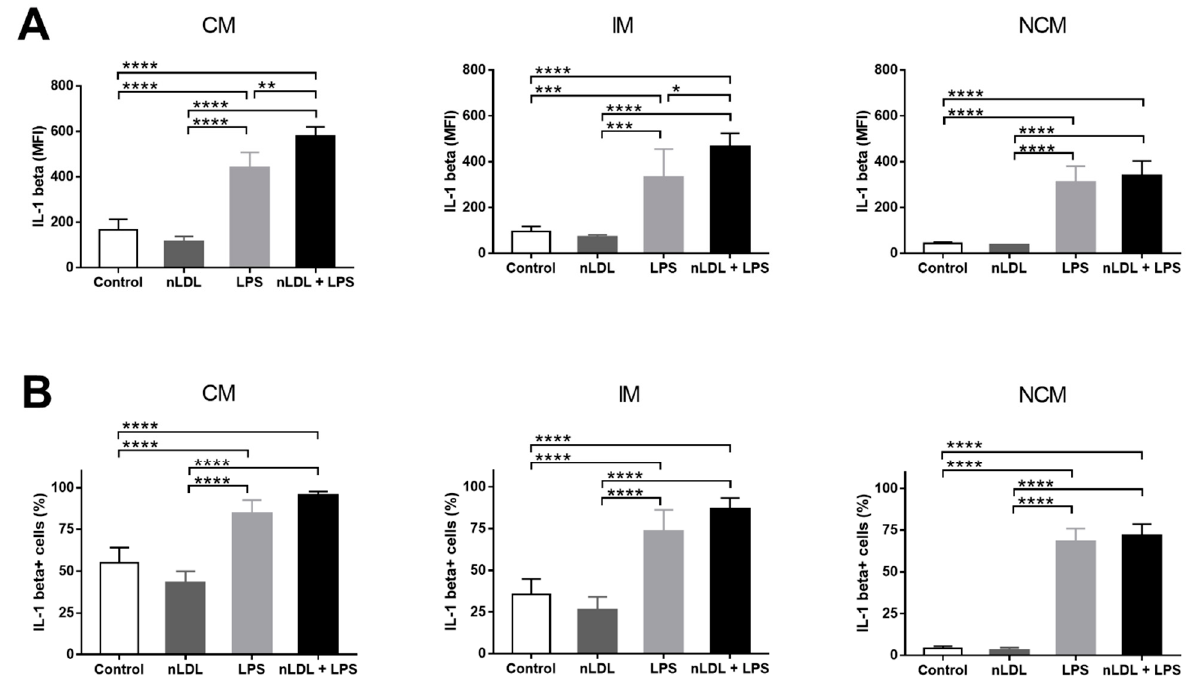
Figure 3. Effects of nLDL and LPS on IL-1 beta production in human monocyte subpopulations. Although no significant differences were found, nLDL tended to decrease IL-1 beta production in CMs, IMs, and NCMs ( A , left, middle, and right panels, respectively). LPS, alone or in combination with nLDL, significantly increased IL-1 beta expression in CMs, IMs, and NCMs ( A , left, middle, and right panels, respectively). Although no significant differences were found, nLDL tended to decrease the percentages of IL-1 beta+ cells in all monocyte subsets ( B , left, middle, and right panels, respectively). LPS, alone or in combination with nLDL, significantly increased the amount of IL-1 beta+ cells in all monocyte subpopulations ( B , left, middle, and right panels, respectively). Cells were incubated in the presence or absence of 100 μ g/mL nLDL and/or 10 ng/mL LPS for 9 h. Data are expressed as mean ± standard deviation. Data were compared using one-way ANOVA followed by the post-hoc Tukey test. Differences were considered significant when p < 0.05. * = p < 0.05; ** = p < 0.01; *** = p < 0.001; **** = p < 0.0001. CM, classical monocytes; IM, intermediate monocytes; NCM, non-classical monocytes; nLDL, native low-density lipoproteins; LPS, lipopolysaccharide; IL-1 beta, interleukin 1 beta; MFI, median fluorescence